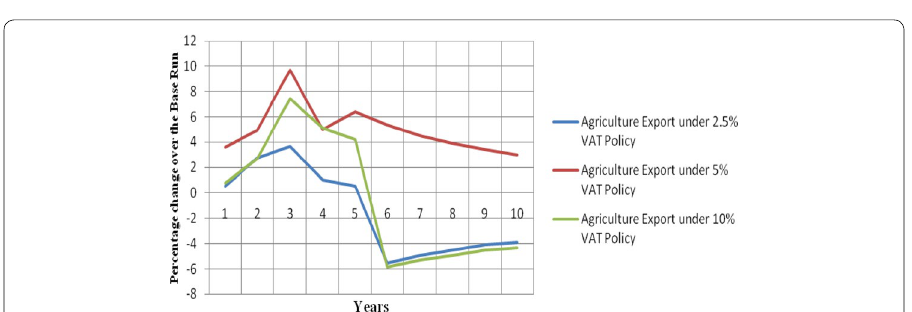
Fig. 44 Changes in agricultural exports under varying VAT rates